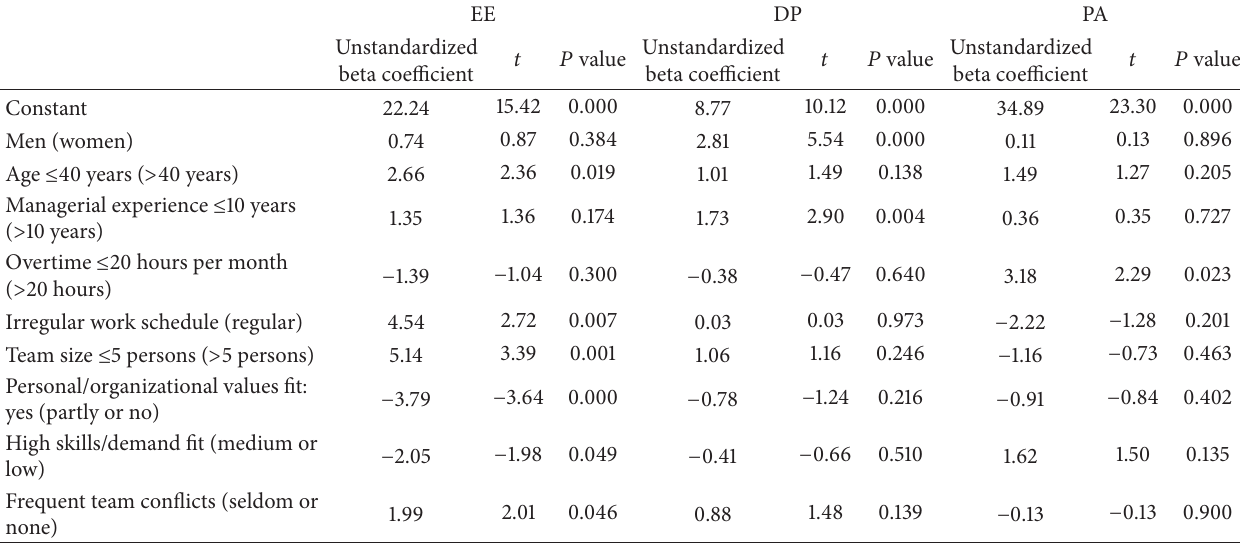
Table 3: Linear regression model of the MBI-HSS subscales among nursing